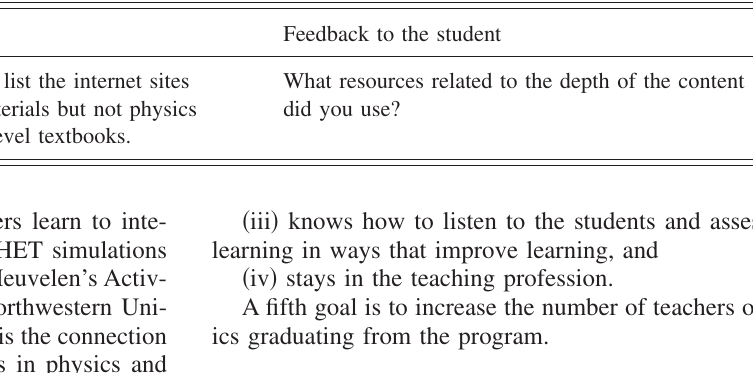
TABLE VI. Rubric for assessment of force diagrams (cid:3) 59 (cid:4) . Needs some improvement Adequate